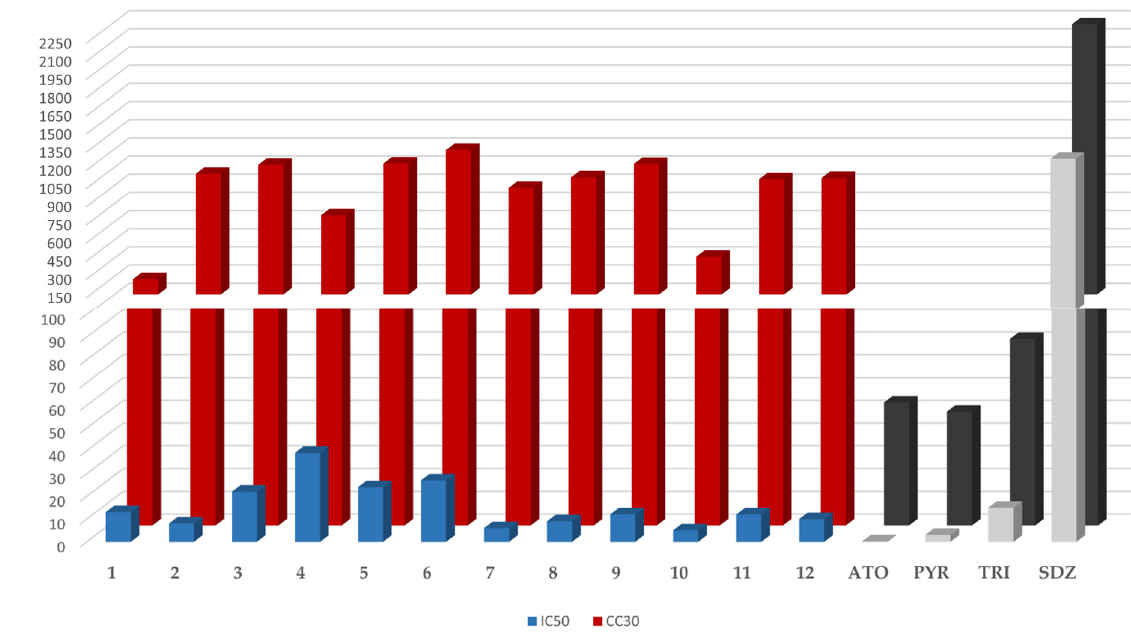
Figure 3. Anti- Tg activity ( IC 50 Tg ) , cytotoxicity ( CC 30 ), and selectivity index (SI) of TZD hybrid molecules ( 1 – 12 ). ATO—atovaquone, PYR—pyrimethamine, TRI—trimethoprim; SDZ—sulfadiazine. For details, see Table 1.